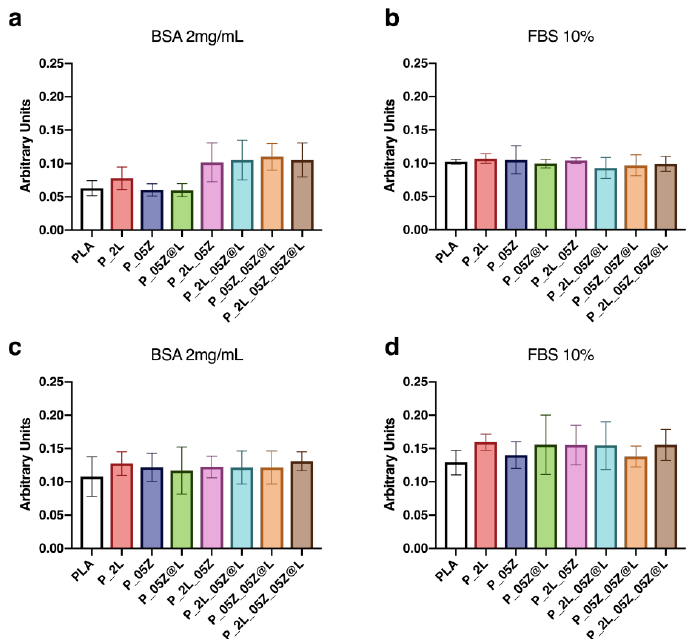
Figure 7. Adsorbed protein on neat PLA, PLA binary, -ternary and -quaternary composite films. ( a , b ) Total adsorbed proteins (absorbance 595 nm) from BSA and 10% FBS after 30 min at 37 °C and ( c , d ) after 24 h at 37 °C. Data are representative of three independent experiments which yielded similar results.